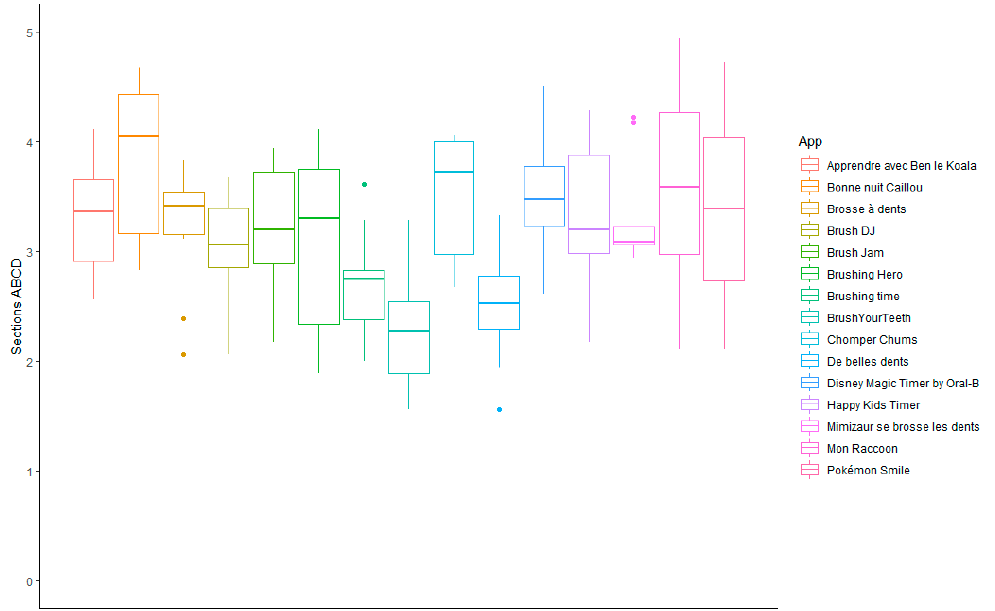
Figure 2. Overall MARS-F qualitative evaluation of oral hygiene-related mobile apps for children available in Sub-Saharan Africa. Section A: engagement; section B: functionality; section C: aesthetics; section D: information.